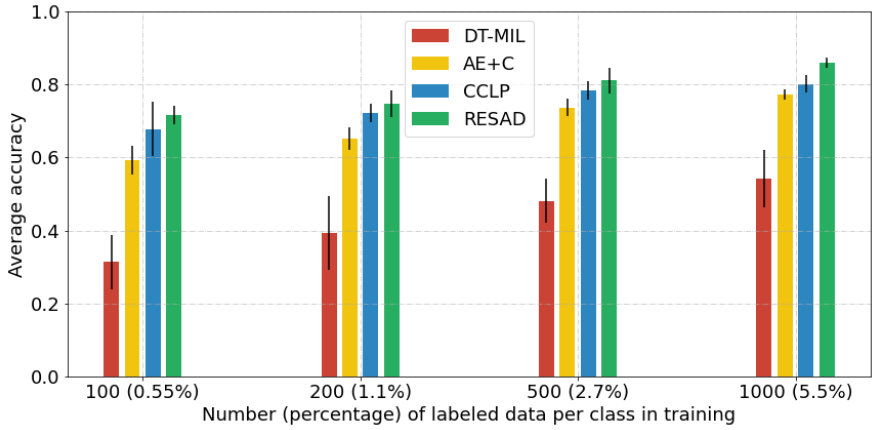
Figure 3. This figure compares performance (average accuracy of classification) of our proposed model (colored green) with multiple baseline methods, such as DT-MIL (red), AE+C (yellow), and CCLP